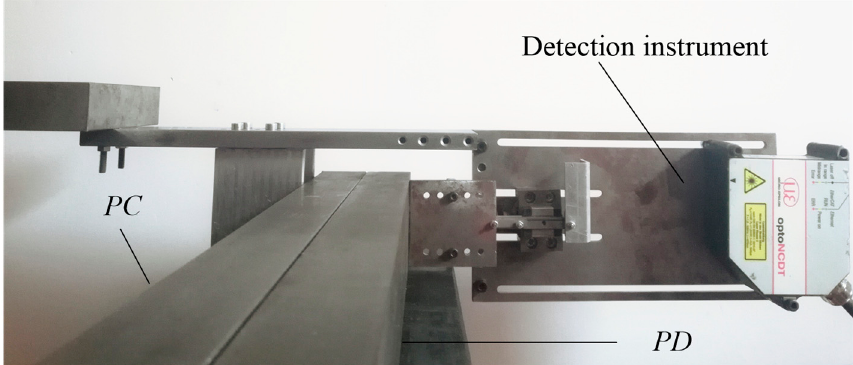
Figure 27. Measurement system of two vertical parallel surfaces.